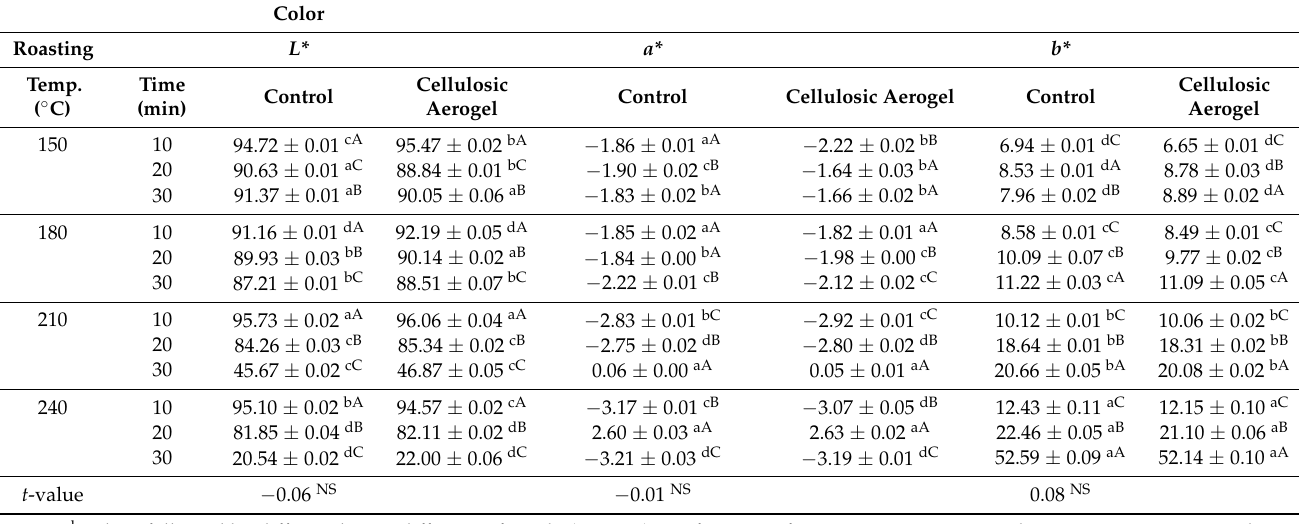
Table 4. The color ( L *, a *, and b *) changes of sesame oil treated with and without 1% of the eulalia-based cellulosic aerogel under different roasting